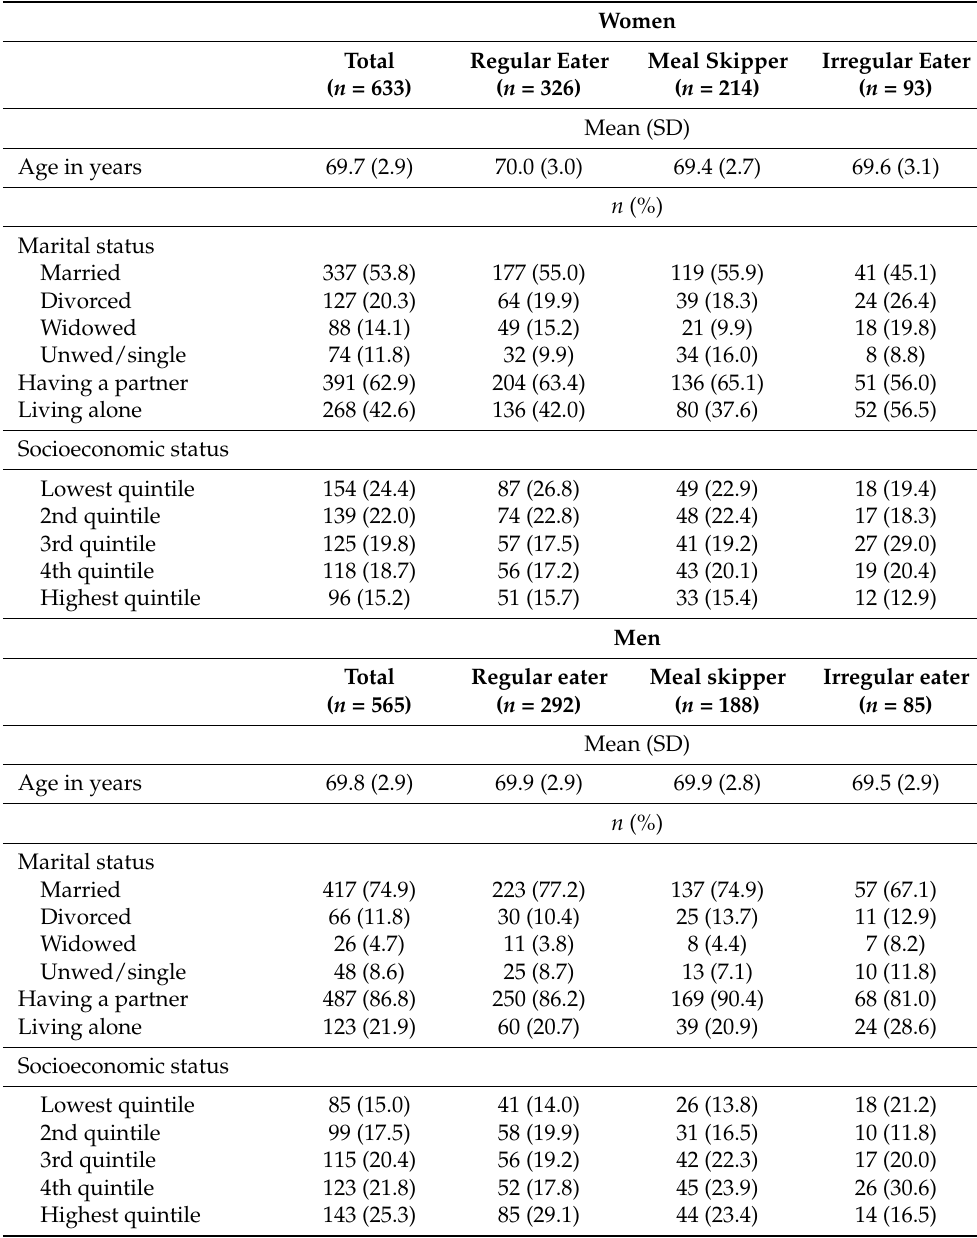
Table 1. Characteristics of the study sample by meal pattern and